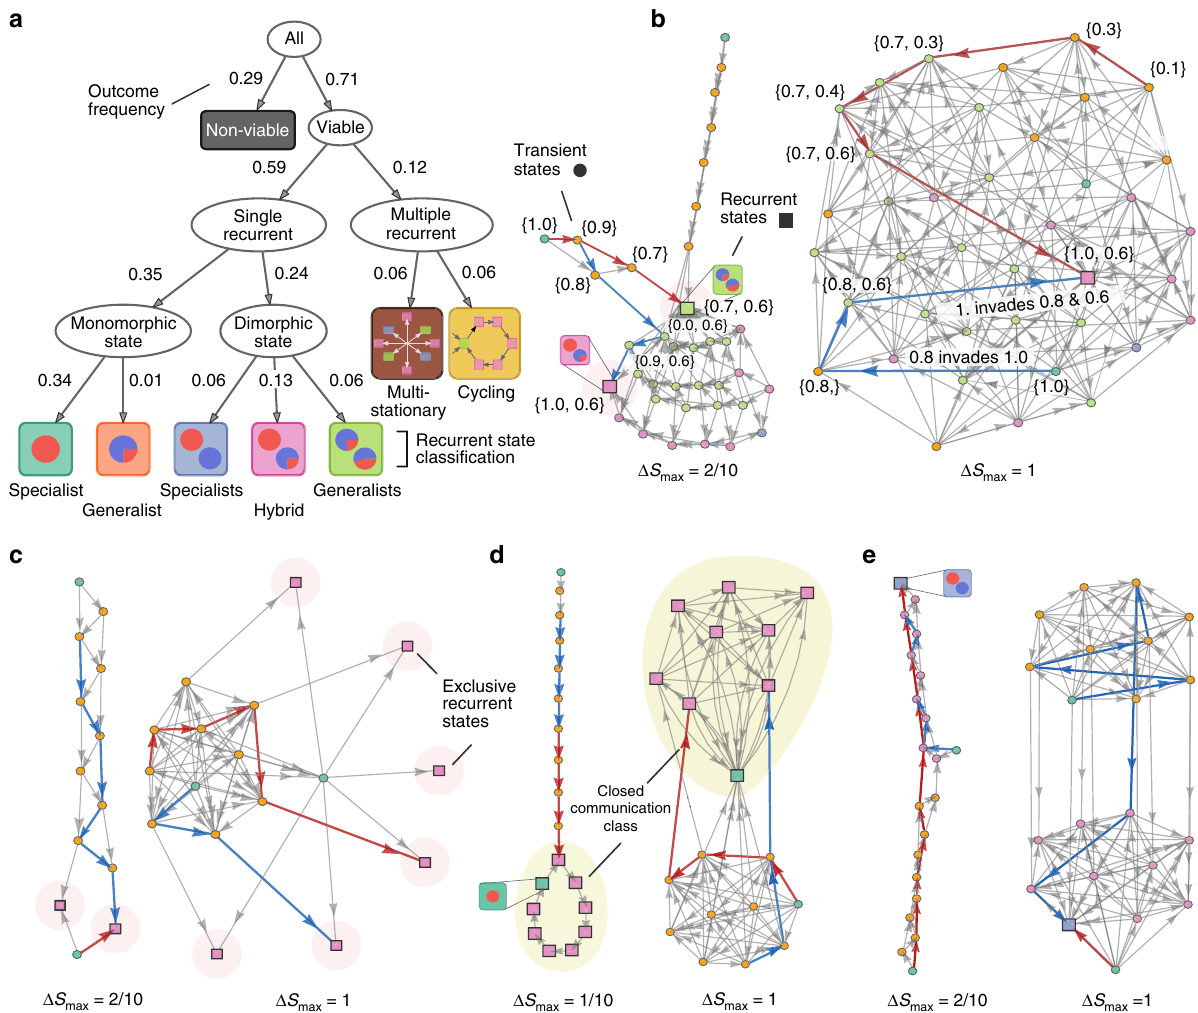
Fig. 3 Our model generates multiple evolutionary outcomes and complex networks of mutational paths. Qualitative properties of the dynamics of adaptation can be visualized and conveyed through graphing the networks of mutational paths. a We hierarchically classify adaptation processes according to their evolutionary outcome using the number and type of recurrent states. Labels show each outcome ’ s frequency obtained by sampling of environmental parameters. b – e The networks of mutational paths from four sets of environmental parameters demonstrate the scope of the model ’ s dynamic and stationary behavior. The maximum size of mutation ( Δ S max ) affects the mutational paths and long-term outcomes of adaptation (compare the recurrent states between the left and right networks). Circles are transient states; squares are recurrent states; colors denote the number, and type of metabolic phenotypes in each state following a . Red and blue traces are examples of mutational paths, which start from an ancestral initial state (always a monomorphic state) and end at a recurrent state. We indicate the phenotype values of residents in some vertices to aid interpretation. b The invasibility relationship between a pair of phenotypes may reverse in the presence of co-residents as a consequence of frequency-dependent modi fi cation of the environment. For example, an s = = 0.8 metabolic generalist can invade an s = 1.0 specialist but the converse is not possible in pairwise competition. When an s = 0.6 generalist is a co-resident, however, the s = 1.0 specialist can invade the dimorphic community of s = 0.8 and s = 0.6 generalists —— and drive s = 0.8 to extinction. c A process with multiple, non-connected recurrent states has more than one evolutionarily stable state, each of which is reached with some probability. d A process where multiple recurrent states are connected exhibits quasi-periodic evolutionary cycling. e An example of a potentially bottle-necked process. The network consists of two highly-connected ( top and bottom ) subgraphs, which are themselves connected via only a few